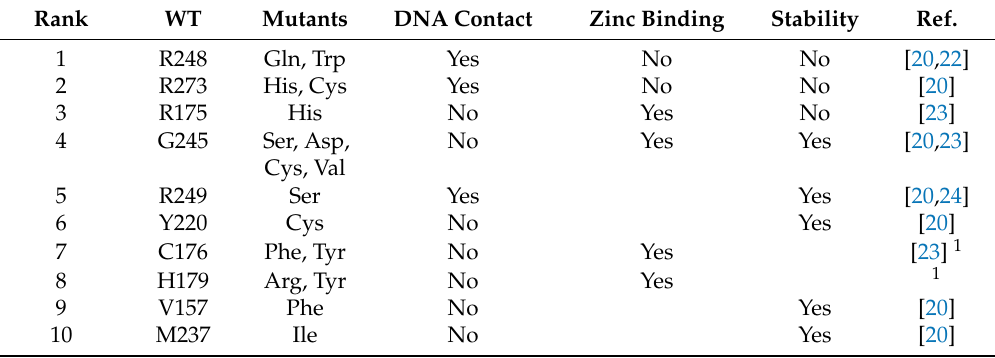
Table 1. Top10 most common somatic p53 mutation sites in IARC Database R20. If multiple mutations at a single site are among the top 50 most common, they are listed in order of decreasing occurrence. Rank WT Mutants DNA Contact Zinc Binding Stability